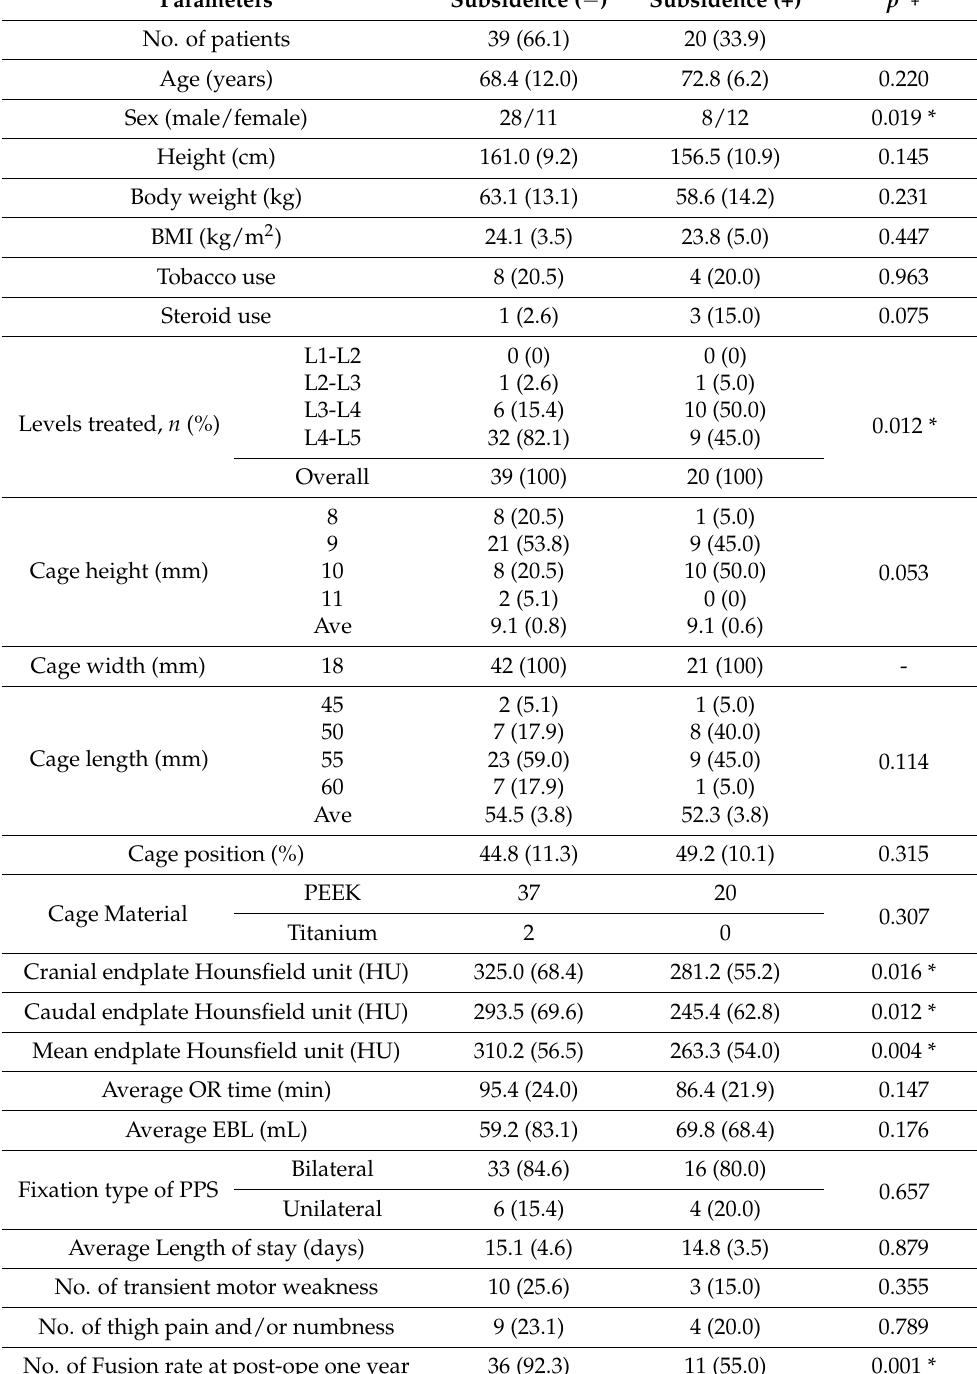
Table 3. Comparison of cage subsidence between two groups. Data presented as mean (SD) or number of patients (%). BMI, body mass index; OR, operation; EBL, estimated blood loss; PPS, percutaneous pedicle screw; * statistically significant; ‡ Comparison among